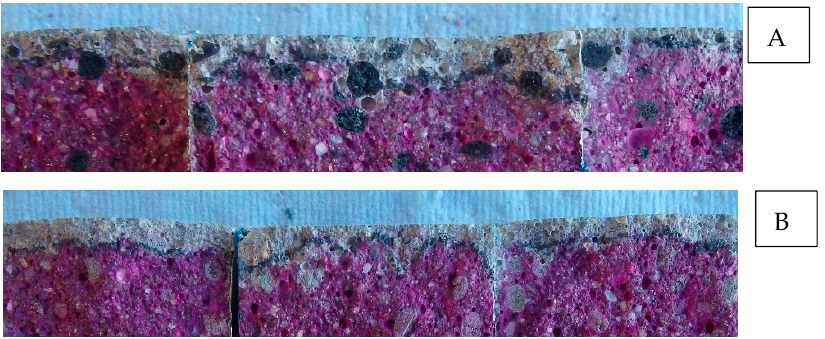
Figure 10. The variability on carbonation depth in ( A ) EC LWA and ( B ) FA 6M LWA mortar samples after being sprayed with phenolphthalein 1%.